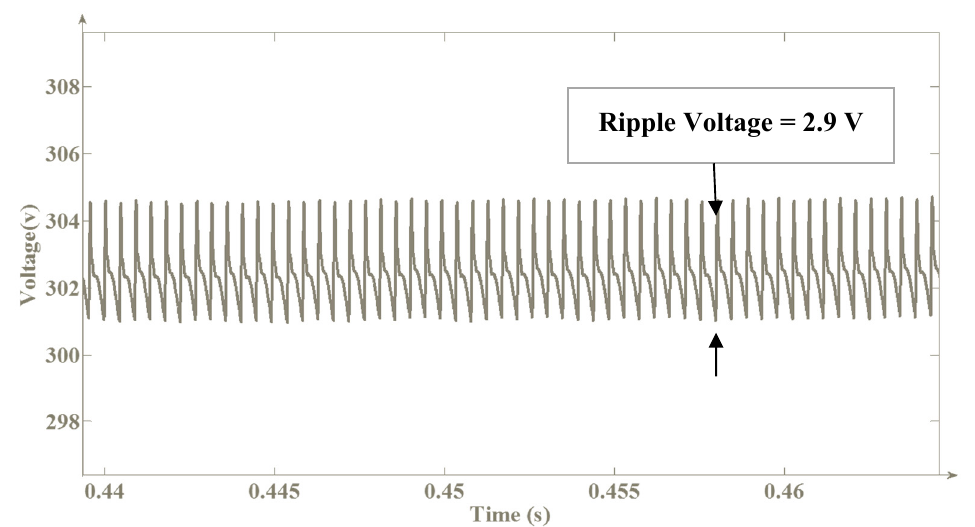
Figure 47. Output voltage ripple waveform for hybrid controller-2-based BDC.